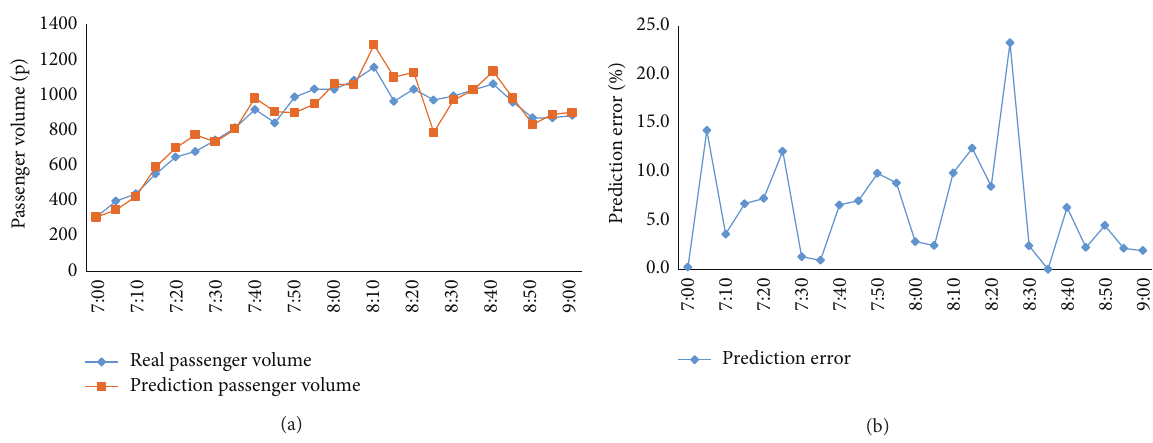
Figure 4: Forecasting result for each 5 minutes in morning peak hour using nonparametric regression.